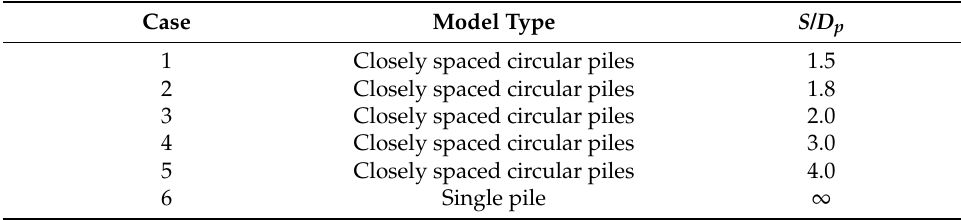
Table 3. Numerical simulations of the present work.